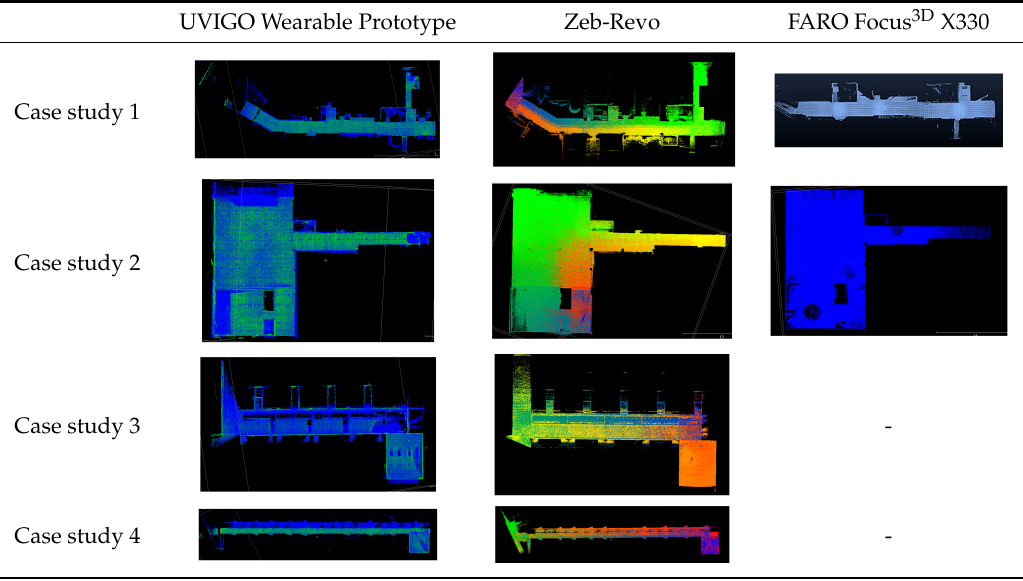
Table 5. Top view of the point clouds generated per system and case study. Differences in color are due to different measurement values of the intensity of the return signal of UVIGO Wearable Prototype and FARO Focus X330. For the case of Zeb-Revo, the representation is done through a pseudocolor according to the distance measured between the system and the